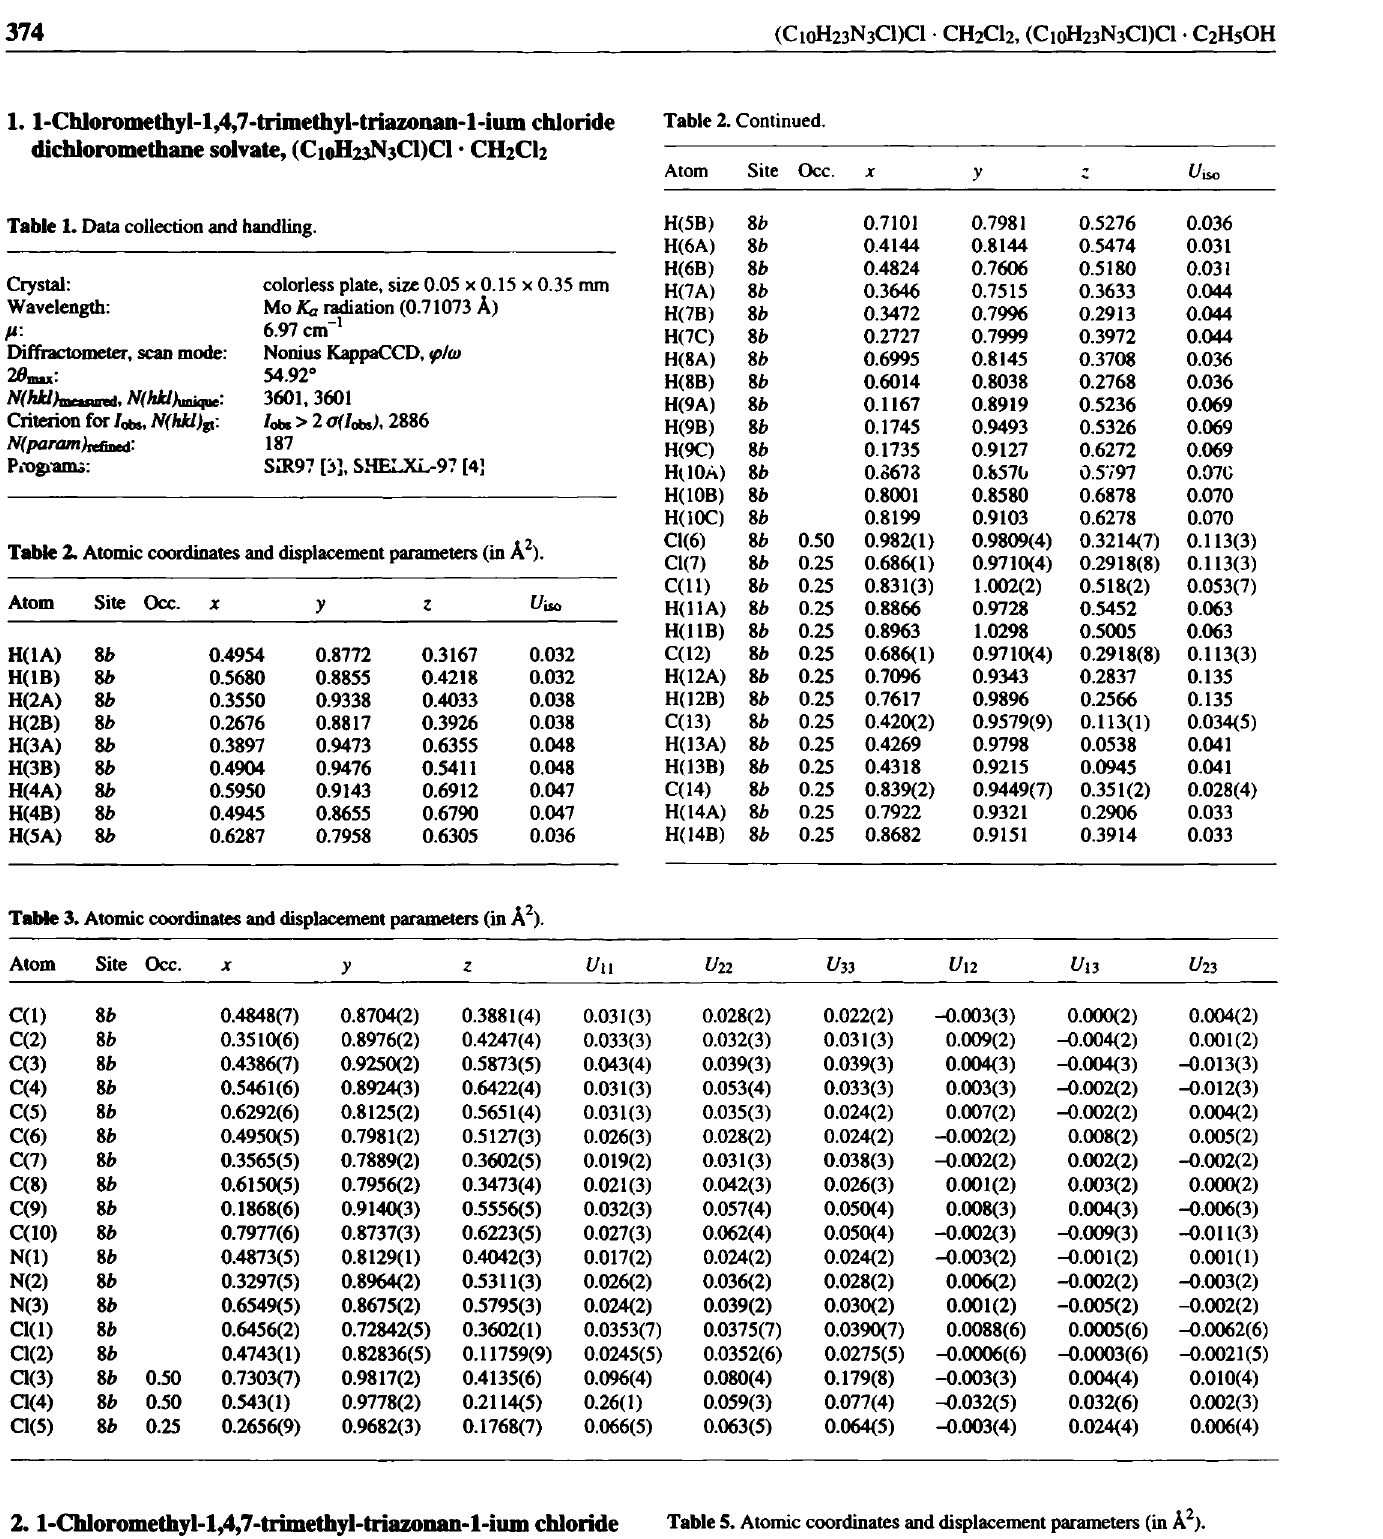
Table 5. Atomic coordinates and displacement parameters (in A 2 ).